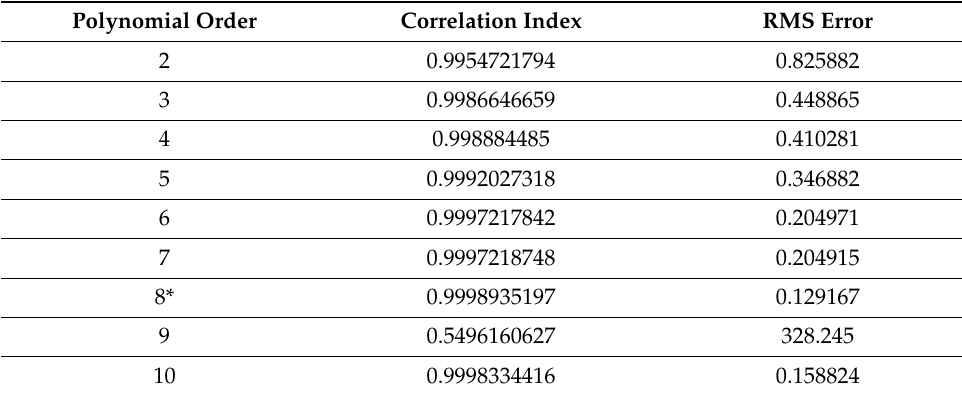
Figure 4. Reduced von Mises stress distribution (MPa) for f 0 = 0.0000, 0.0012, and 0.0024. Table 1. Correlation index and RMS